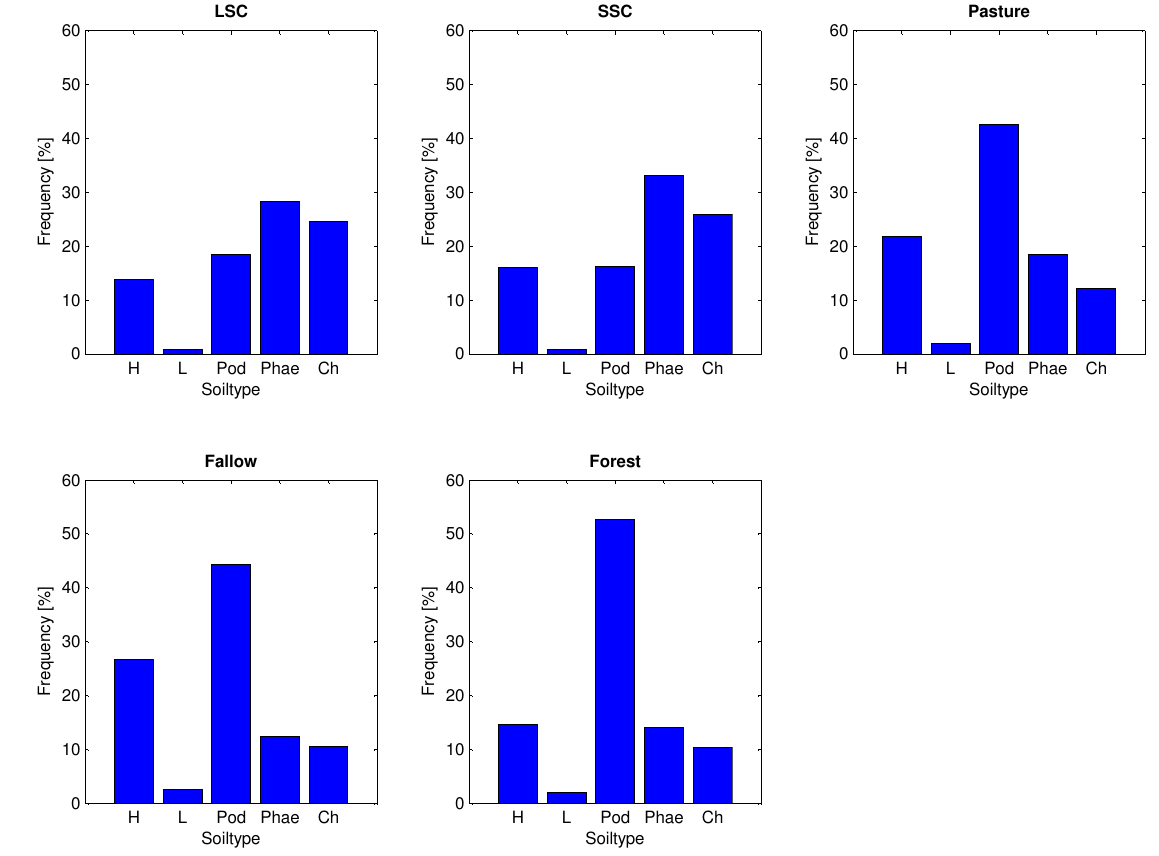
Figure 7. Distribution of the area of each class across underlying soil types (H: Histosols, L: Leptosols, Pod: Podzol, Phae: Phaeozems, Ch: